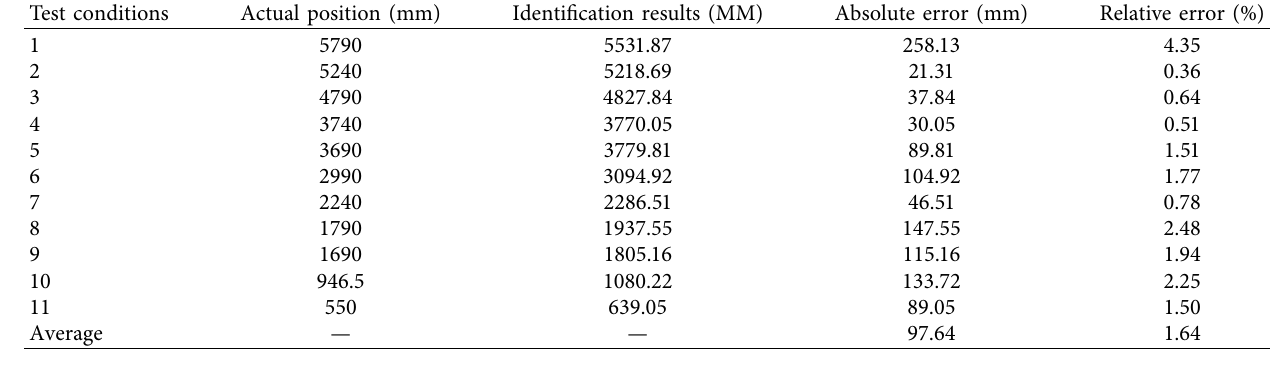
Table 12: GA-BP neural network location results with 5% noise.